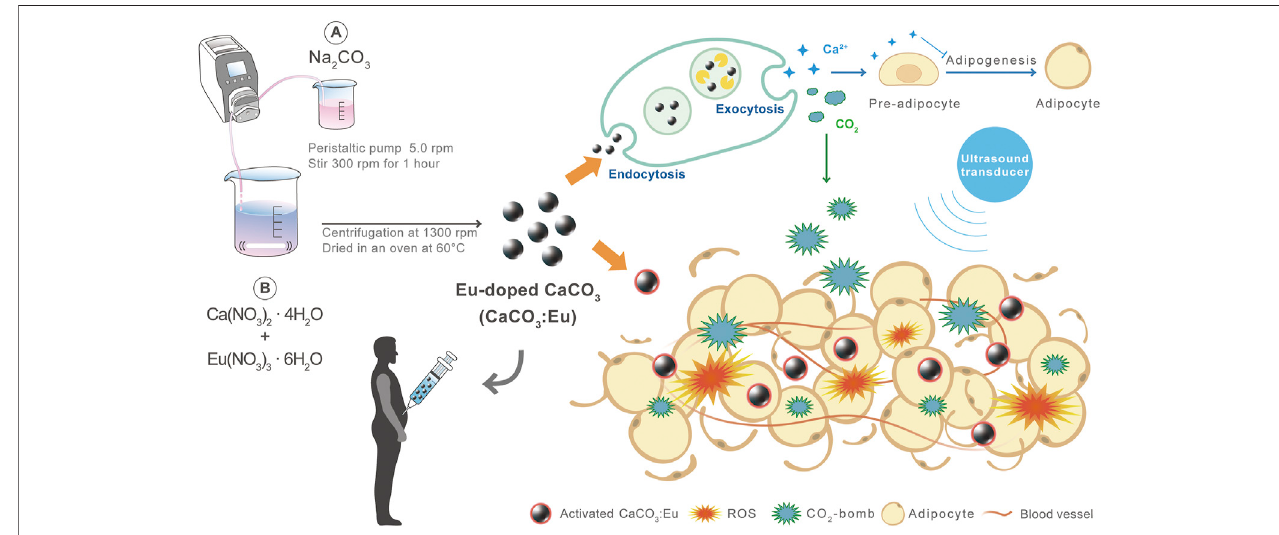
FIGURE1| ThemajormechanismsofCaCO 3 :Euwithlow-intensityultrasoundtreatmenttoeffectivelyremoveawayadipo-tissueandinhibitadipogenesisforbody sculpture.